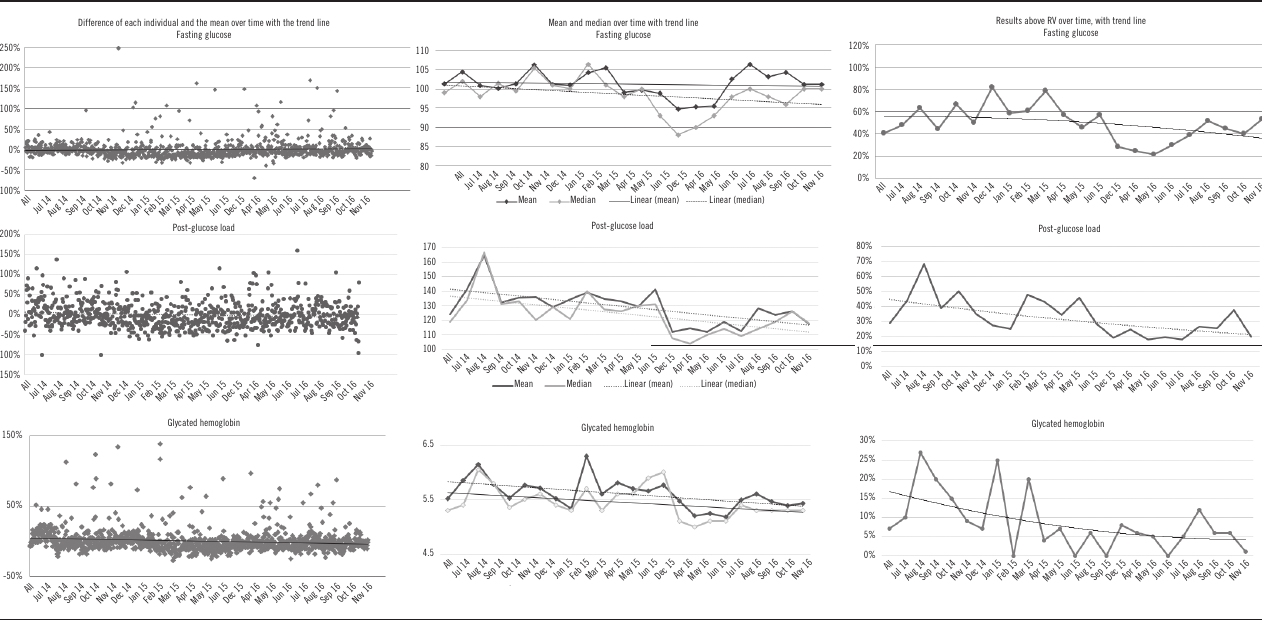
FigurE − Graphical representation of results in analysis of fasting blood glucose ( n = 1,081), post-glucose load ( n = 806), and HbA1C ( n = 1,141), with mean and median in each month, besides the difference of value of each individual compared with the general mean and percentage of results above the RV RV: reference